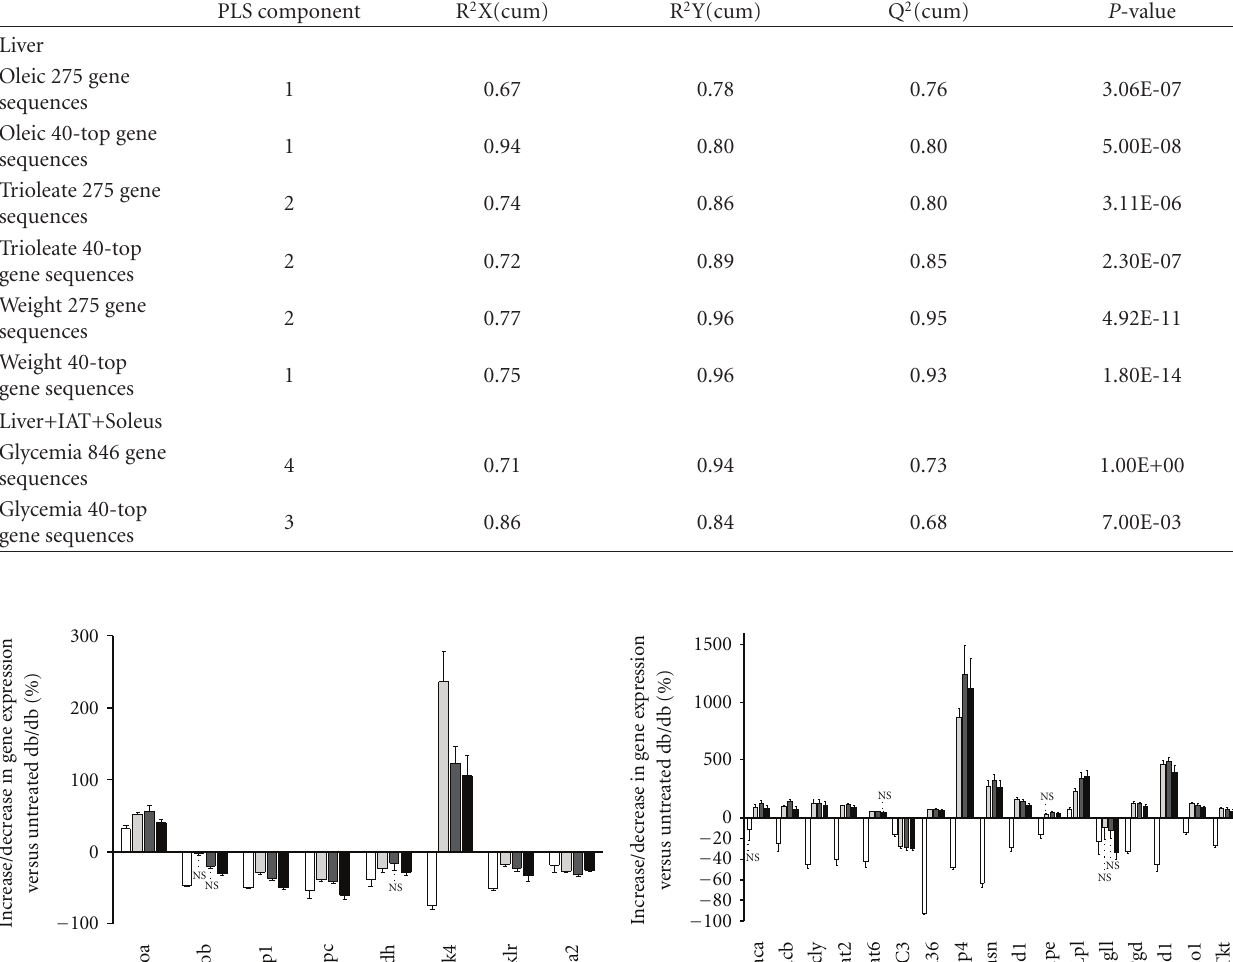
Table 2: Model parameters from multivariate analysis (PLS) based on liver, IAT and muscle gene expression. R 2 X: % of variation of X that explained Y; R 2 Y cum : % of variation of Y explained by the model; Q 2 Y cum : % of variation of Y predicted by the model. Cum are for all PLS components.